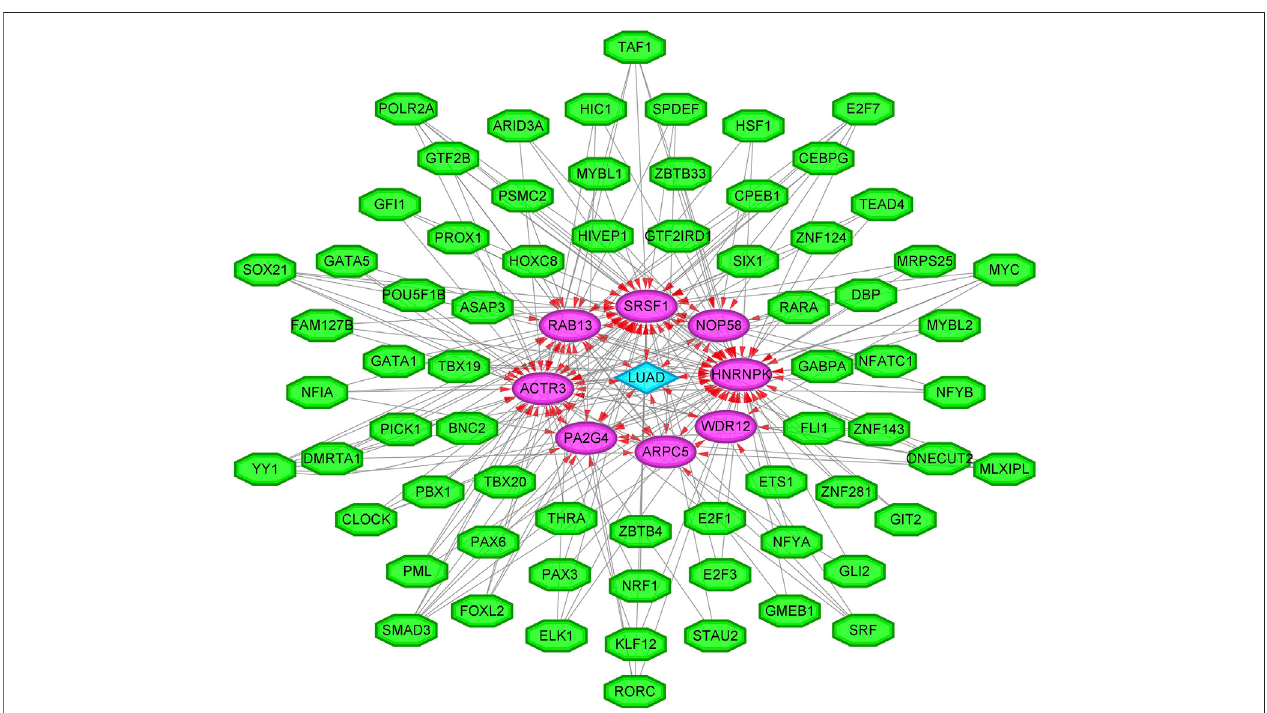
FIGURE 11 | The transcriptional regulatory network of eight hub genes and TFs. TFs, transcription factors. A green hexagon node represents the TFs, a pink circular node represents hub genes, a light blue diamond node represents the lung adenocarcinoma (LUAD), and the interaction is represented by an arrow. The numbers of arrows in the networks demonstrate the contribution of 1 TF to the hub genes; and the higher the degree, the more central the nodes were within the network.